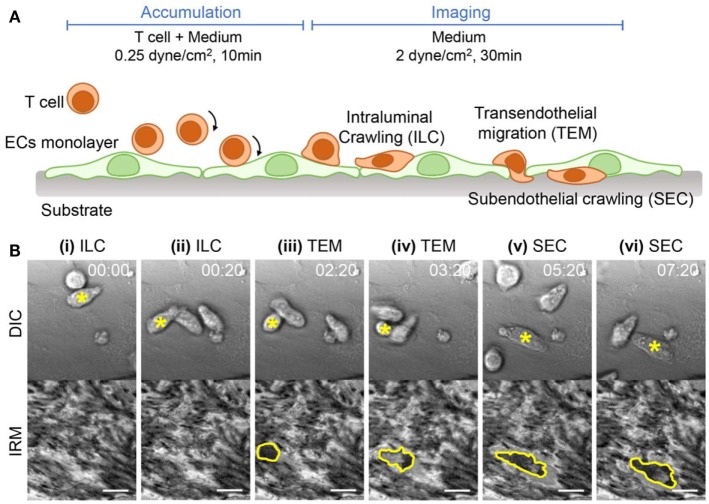
Experimental setup and time-lapse images of T cell adhesion cascades on EC monolayer. (A) Schematic illustration of experimental procedures and expected T cell dynamics. (B) Representative time-lapse differential interference contrast (DIC) (upper) and IRM images (lower). A T cell undergoing transitions of intraluminal crawling (ILC) → transendothelial migration (TEM) → subendothelial crawling (SEC) was marked with a yellow star in each DIC image, and the boundaries of the T cells appeared in IRM images were marked with yellow lines. Scale bar: 10 µm, elapsed time: mm:ss.